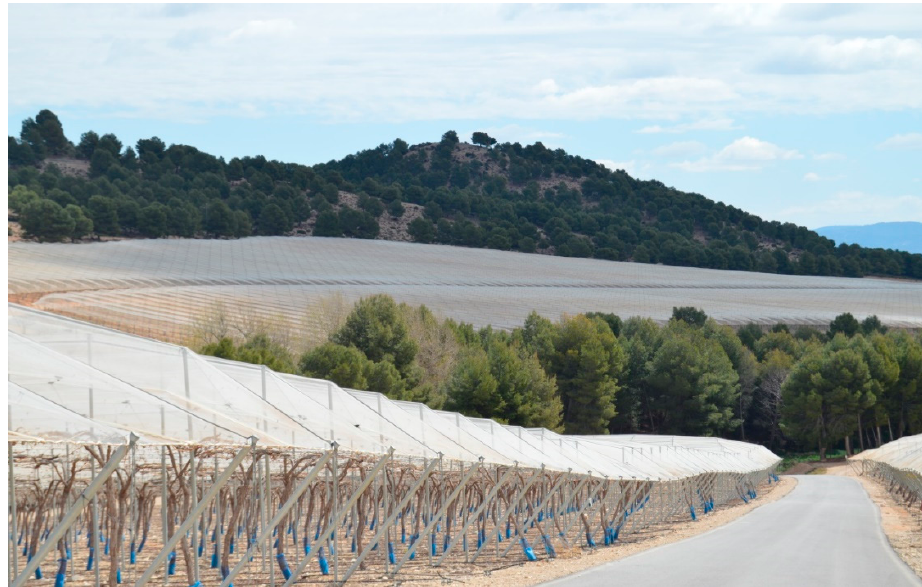
Figure 4. Surface of newly irrigated land (grapes) on the foothills of the Sierra del Gavilán, declared as a Site of Community Interest (LIC) (Archivel, Caravaca de la Cruz). The roads have been conditioned for the entry and exit of heavy load vehicles. Source: Authors.